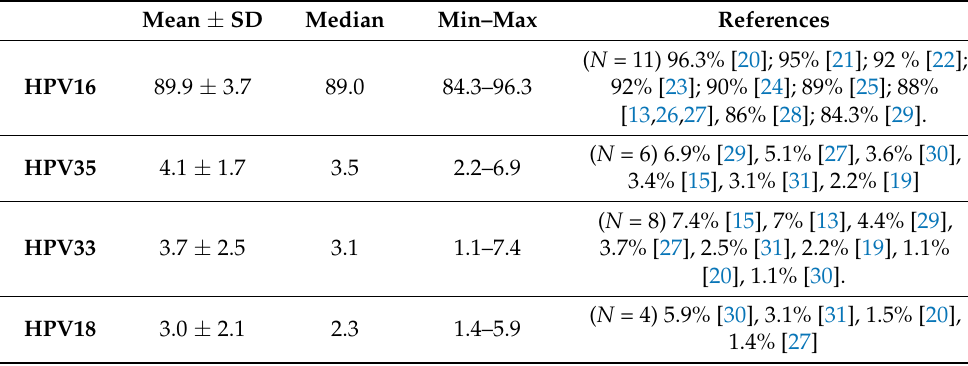
Table 1. The prevalence of HR HPV